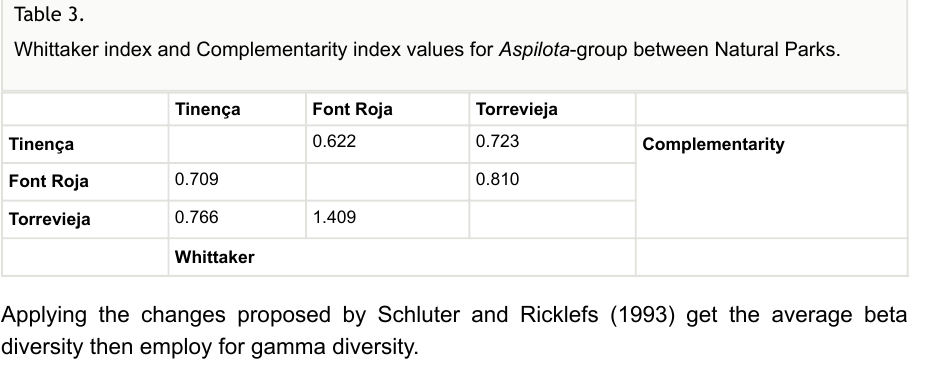
Aspilota-group (Hymenoptera: Braconidae: Alysiinae) diversity in Mediterranean